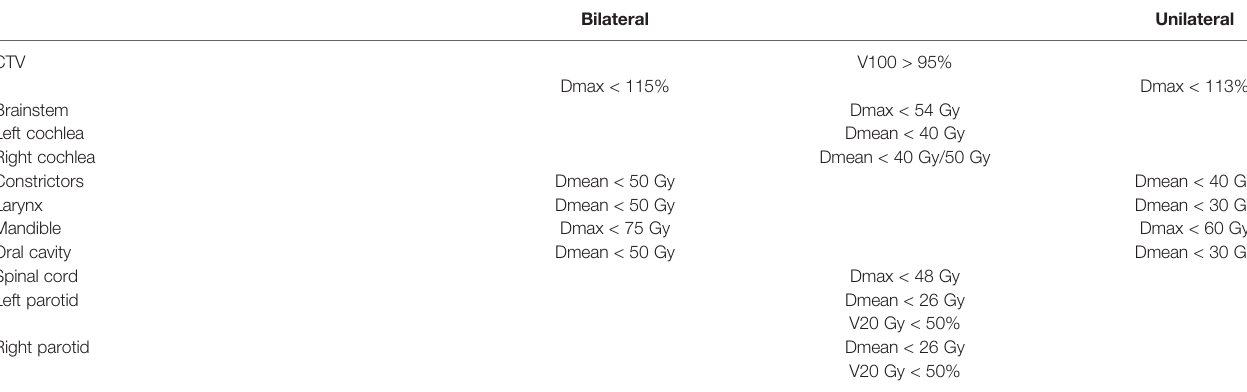
TABLE 1 | CTV and OAR dose constraints for the nominal IMPT plan.